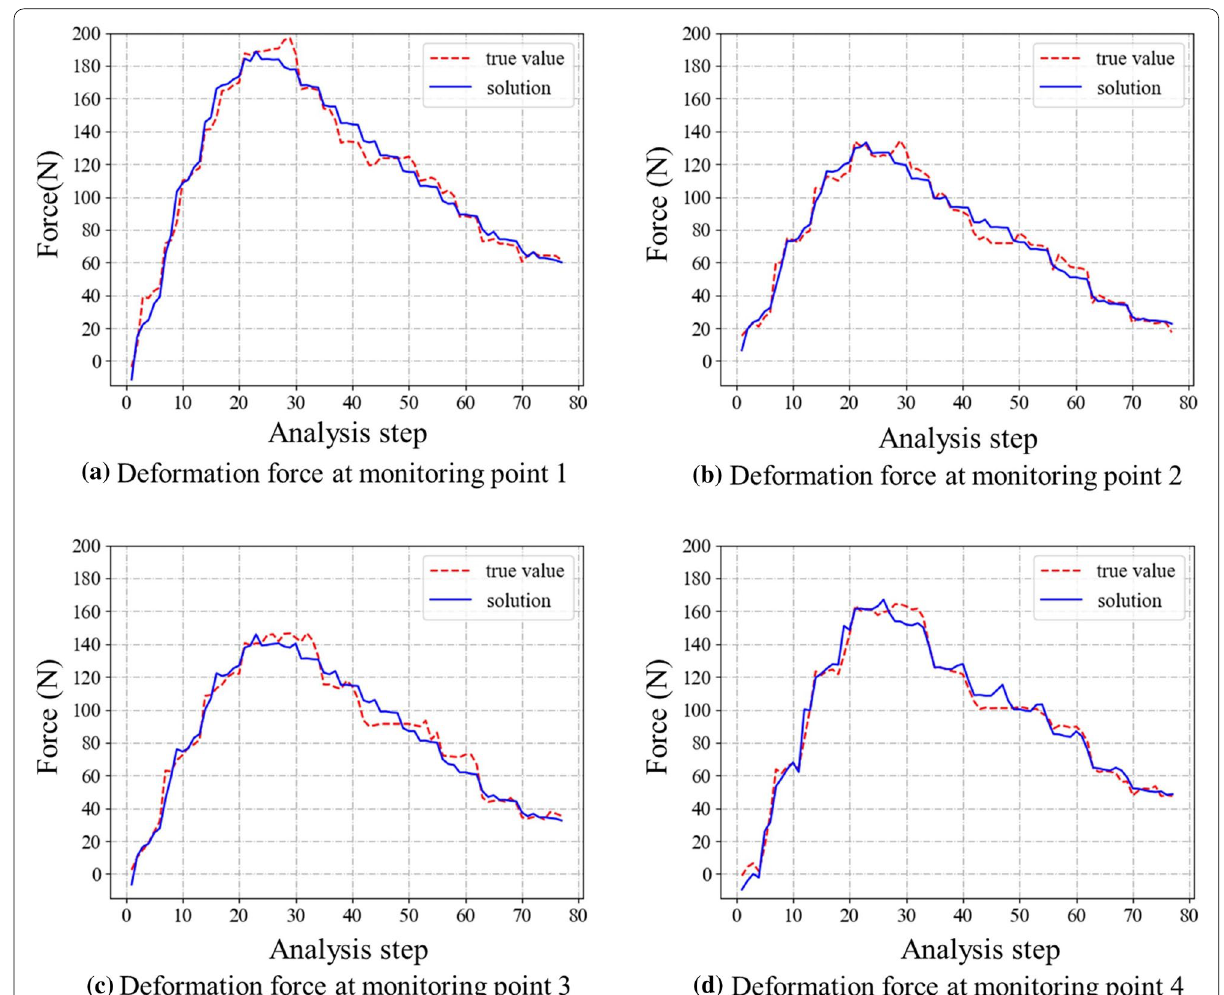
Figure 14 The solved deformation force and compared with the real monitored deformation force for the milling depth from 1 mm to 22